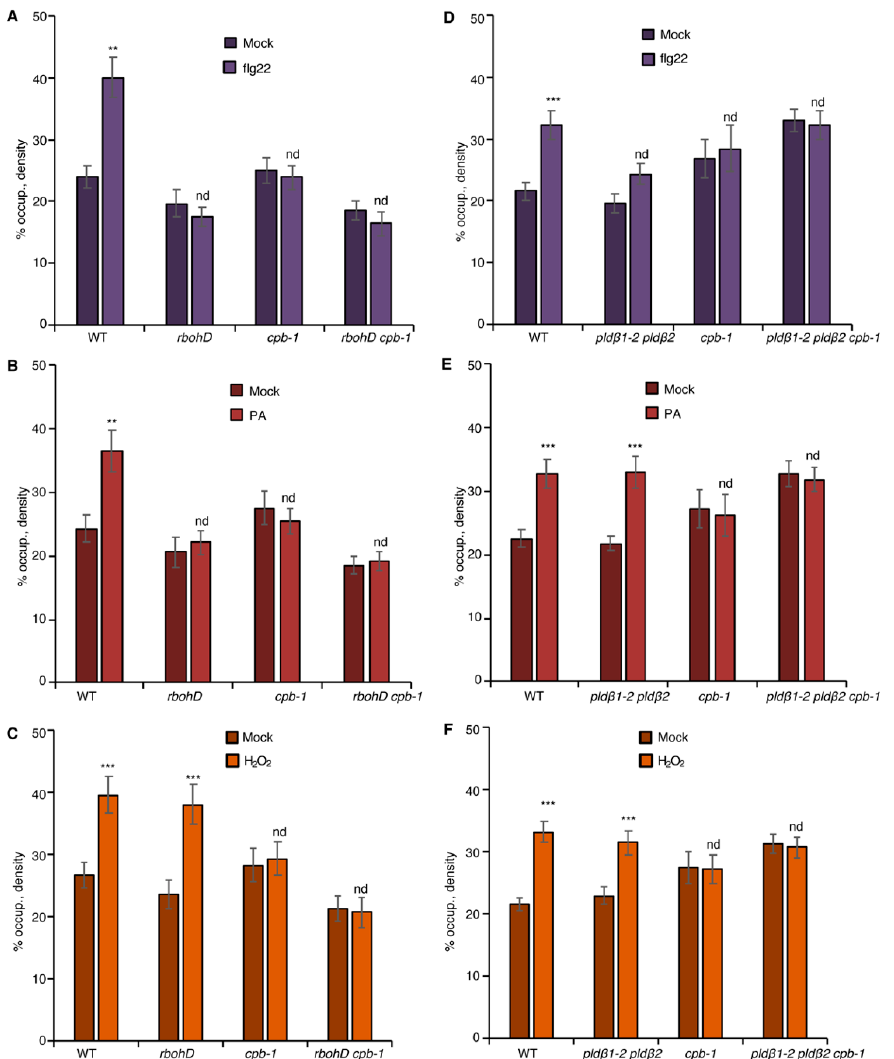
Figure 5. CP transduces both PLD β /PA and RBOHD/ROS signals to regulate actin remodeling. ( A ) Analysis of actin filament abundance in WT, rbohD , cpb-1 , and rbohD cpb-1 seedlings after flg22 treatment for 20 min. Remodeling of actin arrays in rbohD , cpb-1 , and rbohD cpb-1 epidermal cells was insensitive to flg22 treatment. ( B ) Analysis of actin filament abundance in WT, rbohD , cpb-1, and rbohD cpb-1 seedlings after treatment with 50 µM PA for 30 min. Actin filament abundance was significantly increased by exogenous PA treatment in WT but not in rbohD , cpb-1 , or rbohD cpb-1 mutants. ( C ) Analysis of actin filament density in WT, rbohD , cpb-1 , and rbohD cpb-1 seedlings after treatment with 1 µM H 2 O 2 for 20 min. H 2 O 2 triggered significant actin accumulation in rbohD as well as in WT seedlings. In contrast, actin filament remodeling in cpb-1 and rbohD cpb-1 mutants was unresponsive to H 2 O 2 treatment. ( D ) Analysis of actin filament abundance in WT, pld β 1-2 pld β 2 , cpb-1 , and pld β 1-2 pld β 2 cpb-1 after flg22 treatment for 20 min. Actin filaments in pld β 1-2 pld β 2 , cpb-1 , and pld β 1-2 pld β 2 cpb-1 failed to rearrange in response to flg22. ( E ) Analysis of actin filament abundance in WT, pld β 1-2 pld β 2 , cpb-1 , and pld β 1-2 pld β 2 cpb-1 after treatment of 50 µM PA for 30 min. Actin filaments in pld β 1-2 pld β 2 accumulated after PA stimulation, whereas actin filaments in cpb-1 and pld β 1-2 pld β 2 cpb-1 were unresponsive. ( F ) Analysis of actin filament abundance in WT, pld β 1-2 pld β 2 , cpb-1 , and pld β 1-2 pld β 2 cpb-1 after 1 µM H 2 O 2 treatment for 20 min. Similar to WT, actin filaments in pld β 1-2 pld β 2 increased in response to H 2 O 2 treatment. However, cpb-1 and pld β 1-2 pld β 2 cpb-1 were insensitive to the treatment. Values given represent mean ± SE; n = 50 images from 10 seedlings per genotype and treatment; nd, no difference, ** p < 0.01, *** p < 0.001, Student t-test.